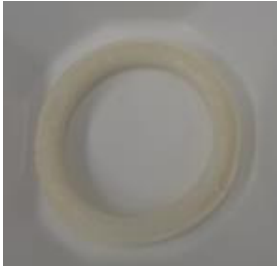
Figure 14. The designed vaginal drug delivery system by our research group [178].